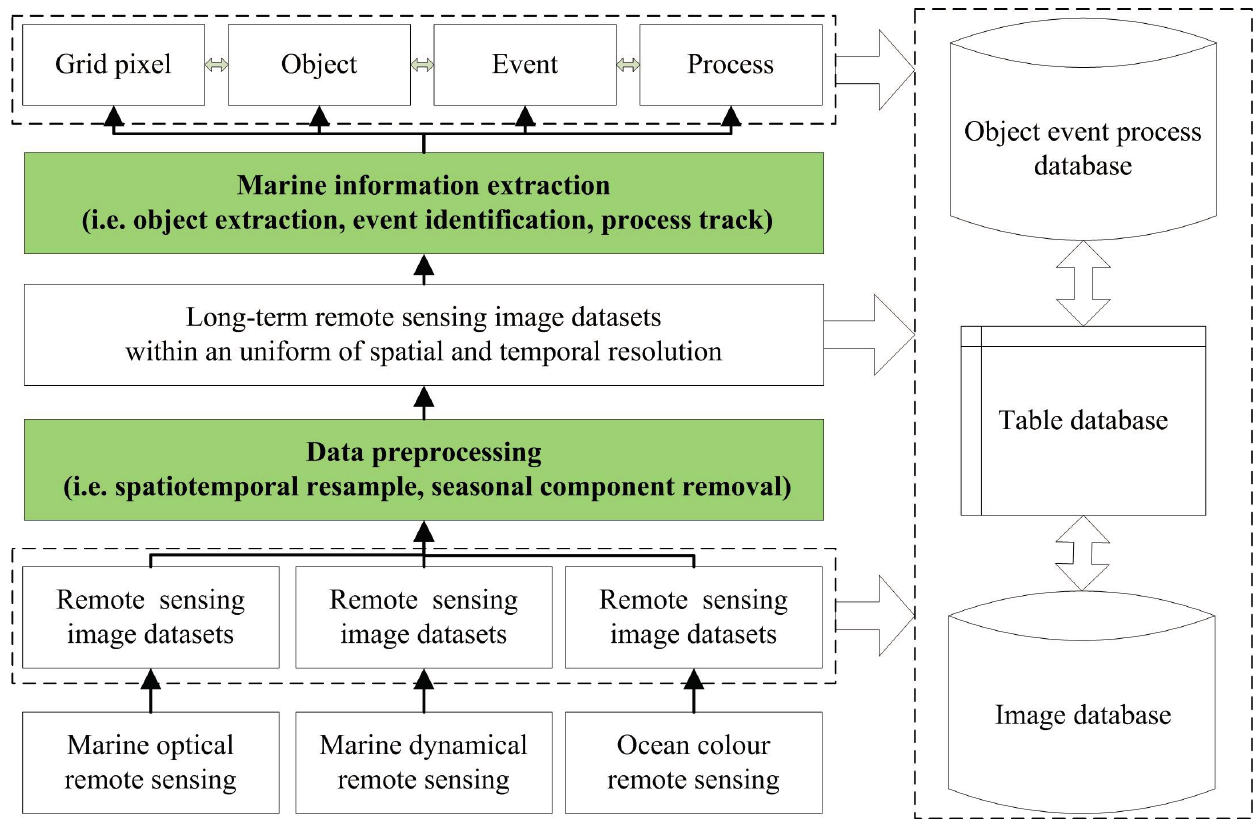
Figure 3. Workflow of the image processing